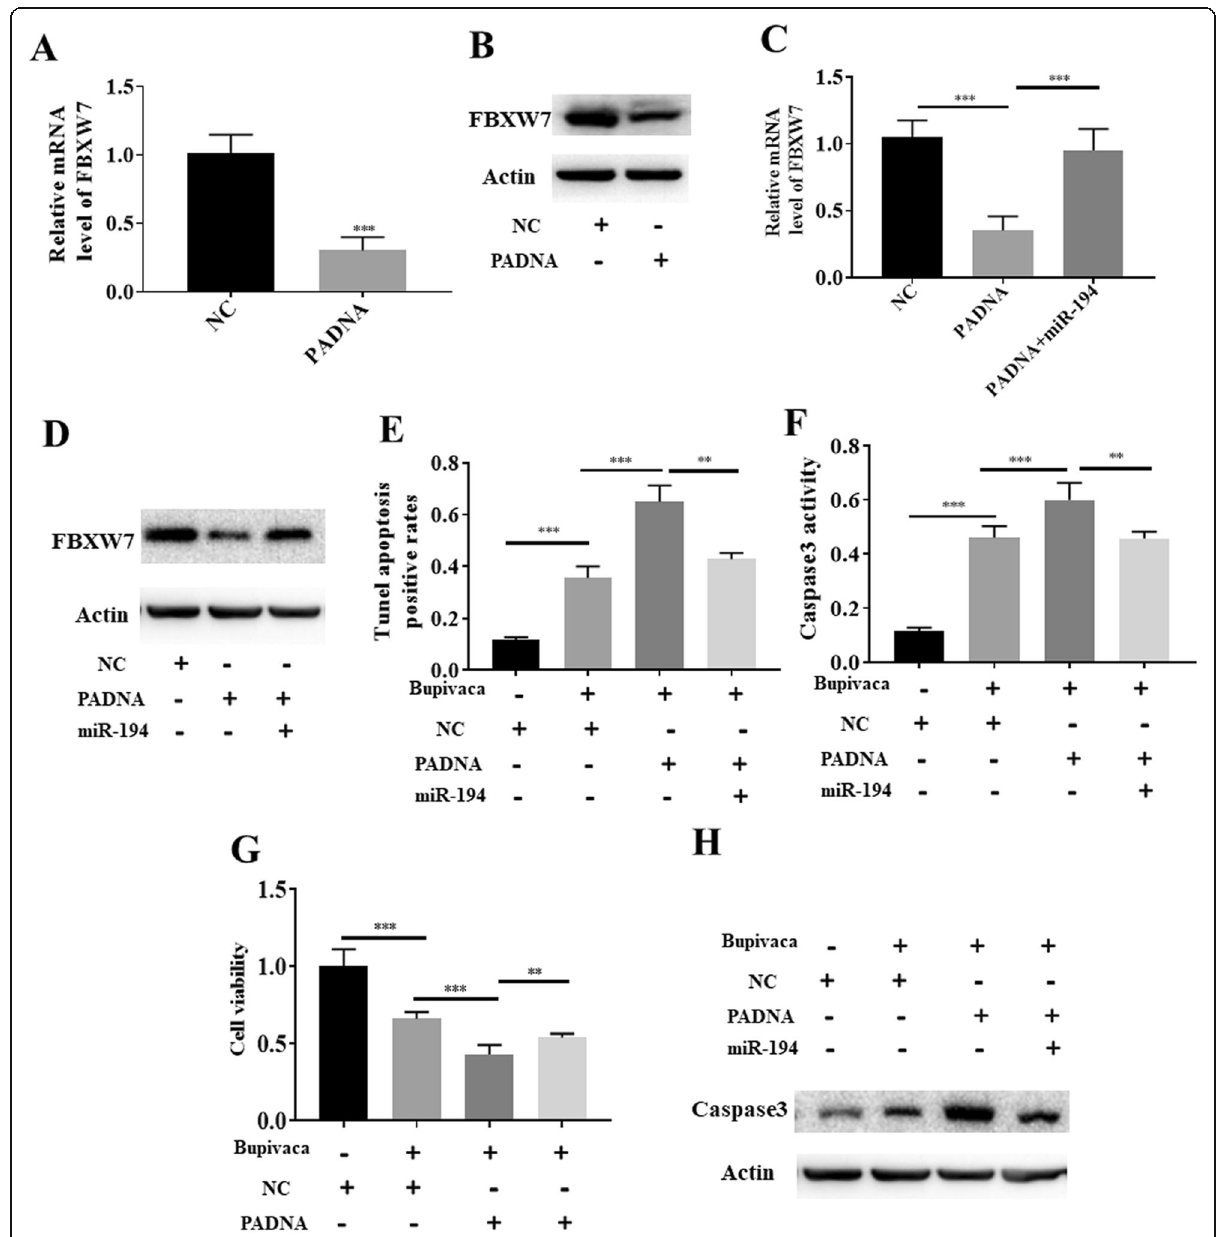
Fig. 5 LincRNA PADNA/miR-194/FBXW7 axis in bupivacaine-induced neurotoxicity. a Knockdown of lincRNA PADNA significantly reduced the expression of FBXW7 mRNA in DRG neurons. b Knockdown of lincRNA PADNA significantly reduced the expression of FBXW7 protein in DRG neurons. c , d Knockdown of miR-194 reversed the expression of FBXW7 in DRG neurons which is inhibited by knockdown of lincRNA PADNA. e Knockdown of miR-194 reversed the up-regulated percentage of apoptotic of DRG neurons which is induced by the knockdown of lincRNA PADNA. Cells were treated with 1mM bupivacaine. f Downregulated of miR-194 reversed the up-regulated caspase3 activity of DRG neurons which is induced by the knockdown of lincRNA PADNA. Cells were treated with 1mM bupivacaine. g Downregulated of miR-194 reversed the down-regulated cell viability of DRG neurons which is induced by the knockdown of lincRNA PADNA. Cells were treated with 1mM bupivacaine. h Downregulated of miR-194 reversed the up-regulated expression of caspase3 protein in DRG neurons which is induced by the knockdown of lincRNA PADNA. Cells were treated with 1mM bupivacaine. Data are Mean±SD with n =3 independent biological cultures. * p <0.05 and ** p